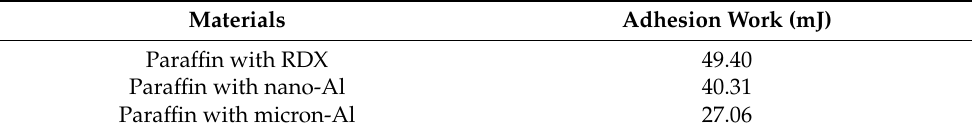
Table 6. Adhesion work between paraffin wax with RDX and aluminum with different size.